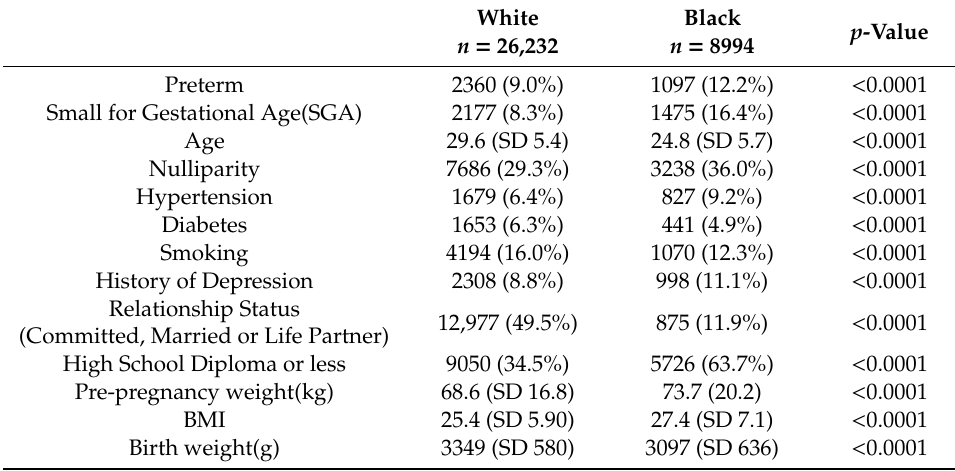
Table 1. Racial di ff erences in baseline characteristics of the entire eligible cohort ( n = 37,474).